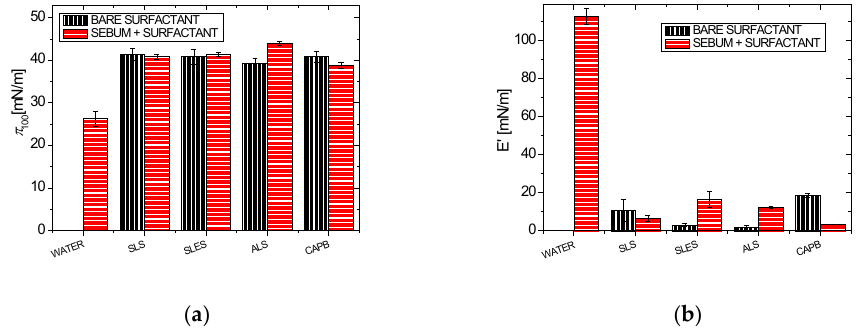
Figure 5. Surface pressure after 100 min, π 100 , ( a ) and surface compression elasticity, E’ , ( b ) for the bare surfactants and Milli-Q water (black bars with vertical strips) and the synthetic sebum monolayers in contact with the surfactants/Milli-Q water in the subphase (red bars with horizontal strips). All monolayers were compressed to π 0 = 30 mN/m prior to introduction of the surfactants and the final concentration in the subphase was equal to